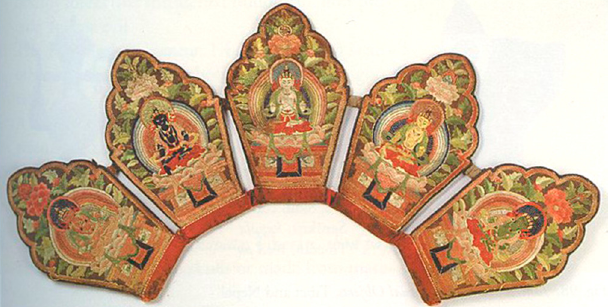
Figure 21. Pa ῆ ca jina Crown, Tibet. https://www.himalayanart.org/items/59558/images/primary#-55,-1300,2524,0. Copyright@ 2018 Himalayan Art Resources Inc.